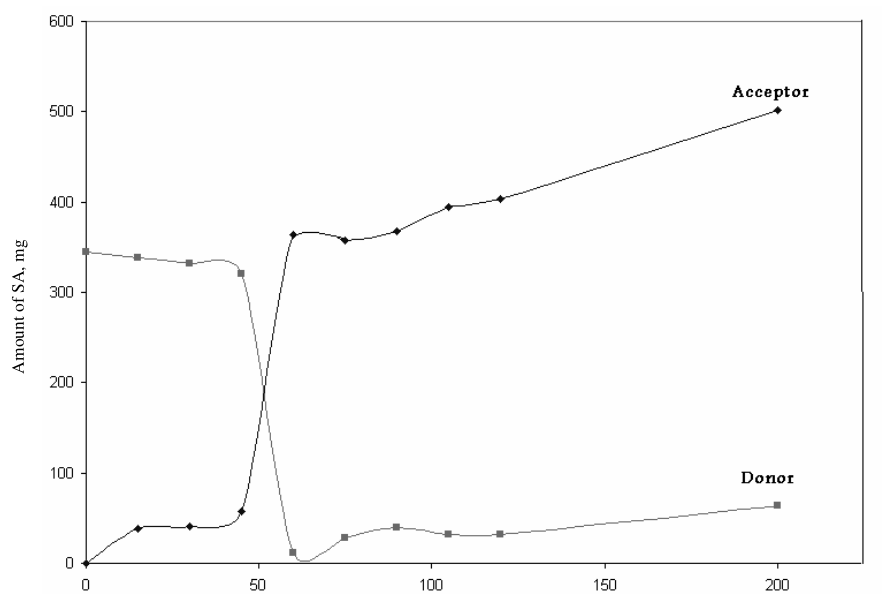
Figure 2. Effect of time of permability of SA in donor and receptor (PEG-PVA/ Tannin membrane)